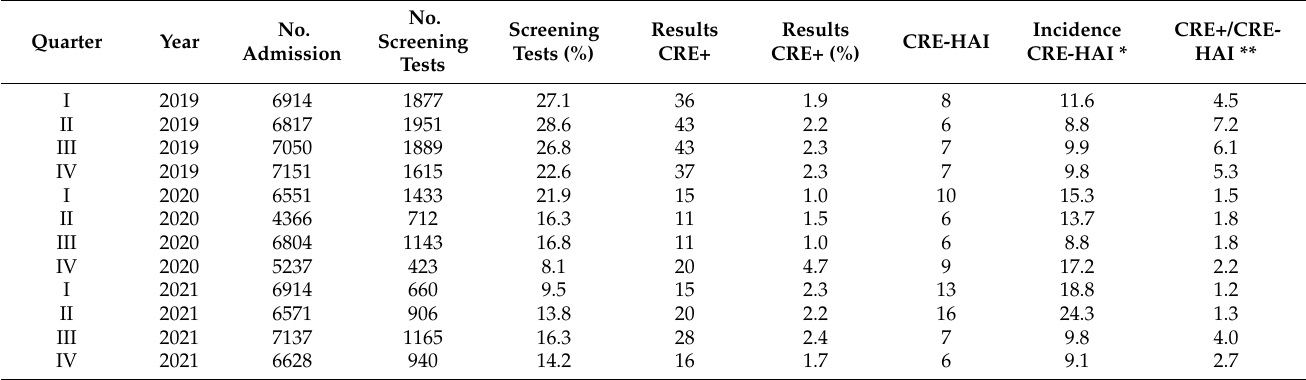
Table 2. Characteristics of screening tests and results of it.